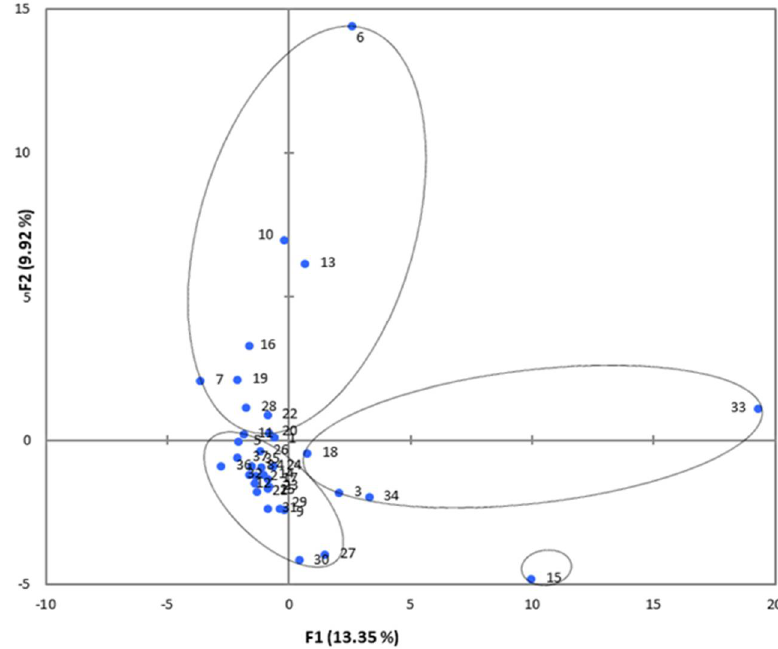
Figure 4. Positions of PC scores of all of the studied mango cultivars according to PC1 and PC2.